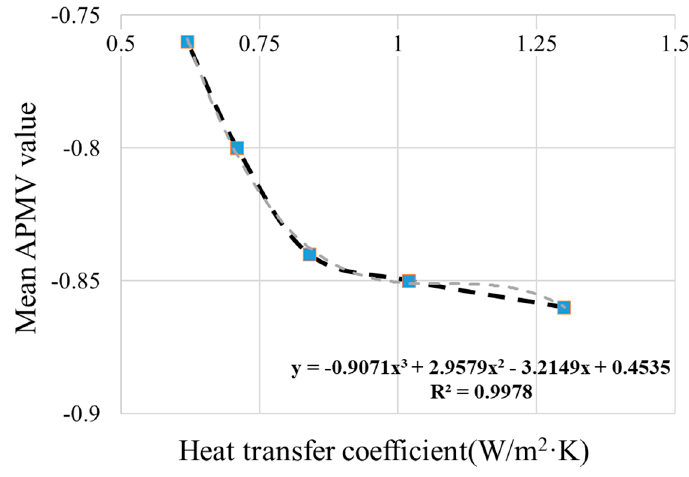
Figure 8. Relationship between indoor thermal comfort and heat transfer coefficient.